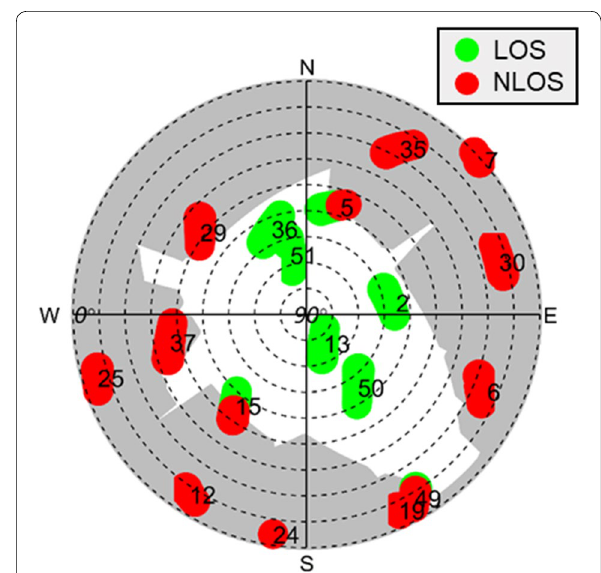
Fig. 14 Sky plot from ground truth label at